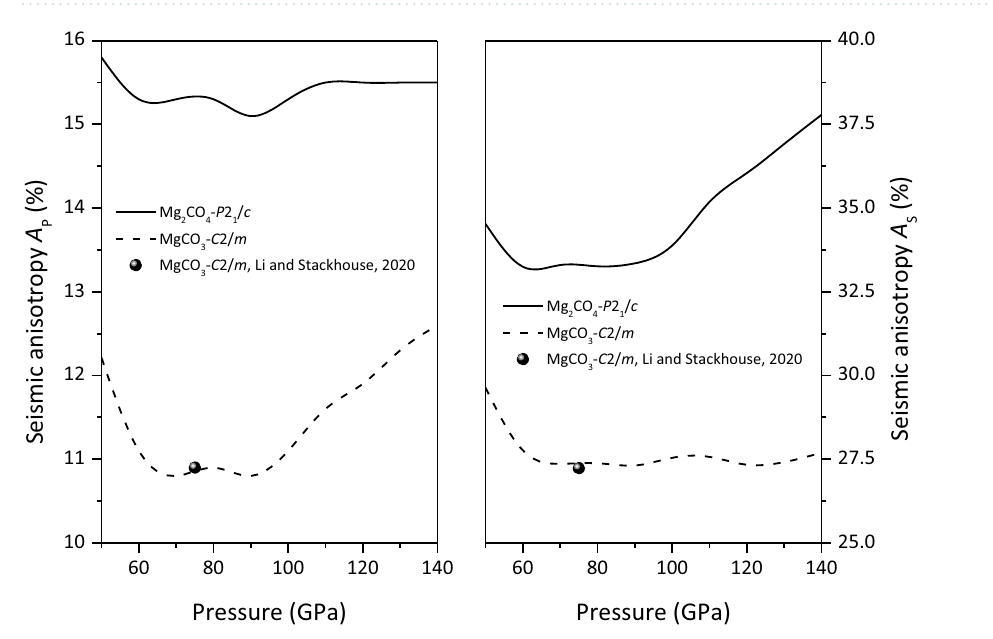
Figure 11. Seismic anisotropy of MgCO 3 - C 2 /m and Mg 2 CO 4 - P 2 1 /c